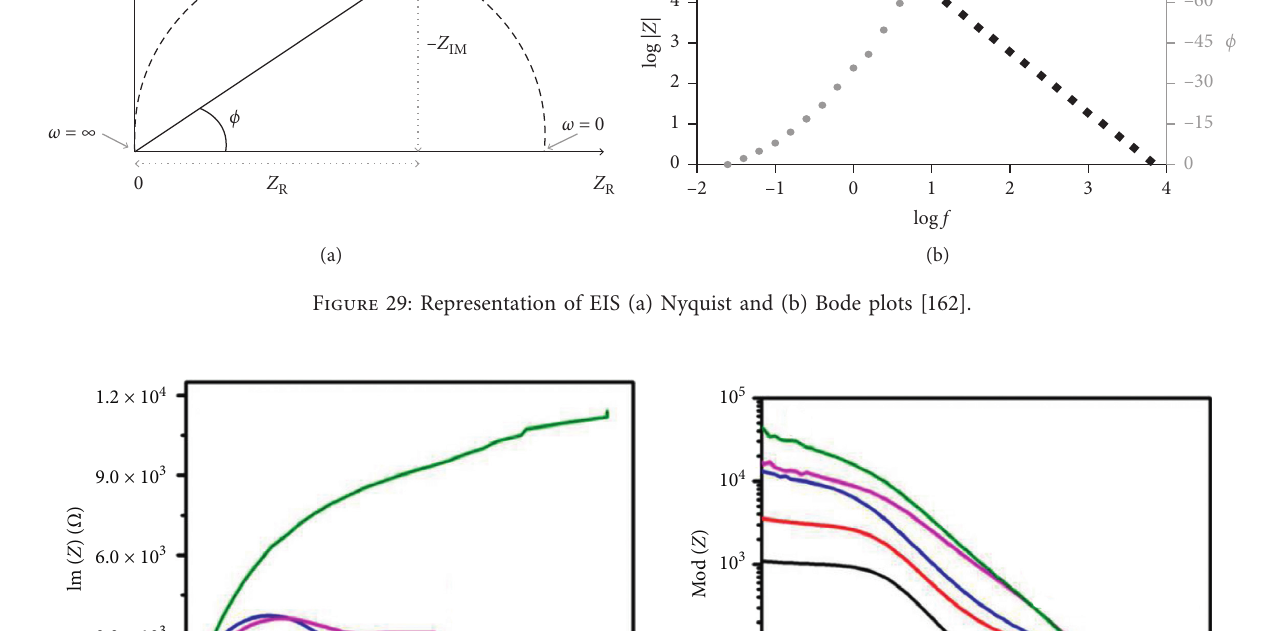
2 synthesised at different conditions